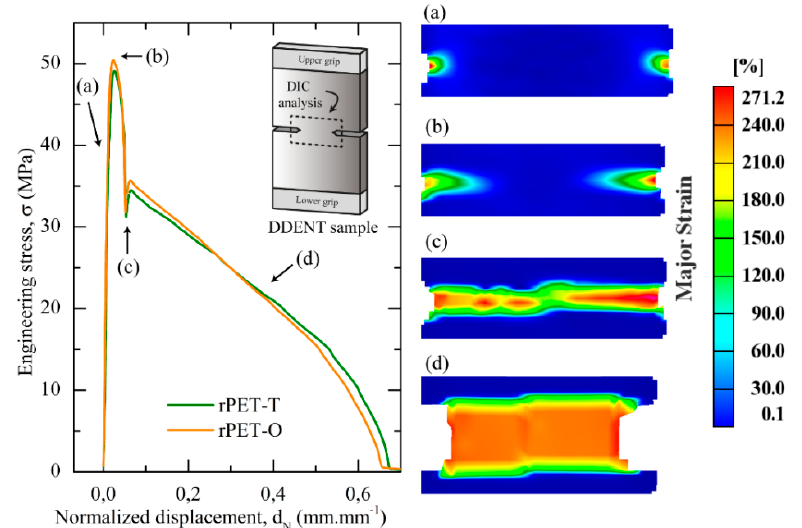
Figure 6. Engineering stress-normalized displacement curves for unaged DDENT samples tested at 10 mm·min − 1 . The displacement was normalized by a ligament length of 16 mm. Digital image correlation (DIC) analysis allowed to determine the strain field surrounding the ligament zone in some determined points.